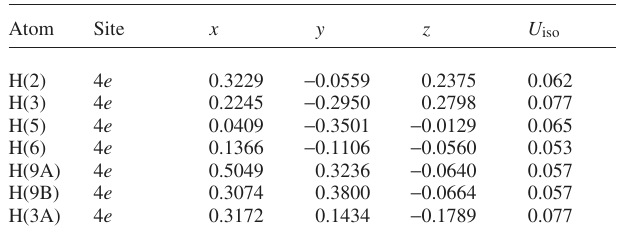
Table 2. Atomic coordinates and displacement parameters (in Å 2 ) . Table 1. Data collection and